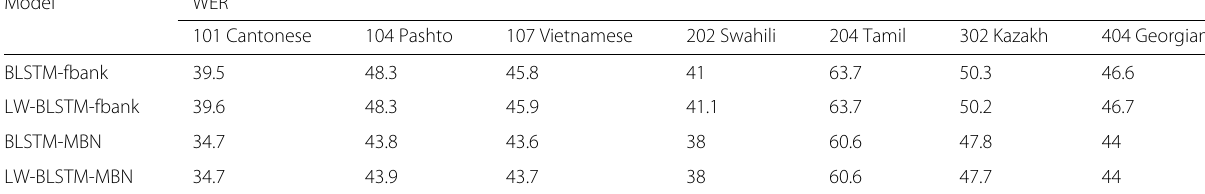
Table 9 WER (%) of the BLSTMs and LW-BLSTMs for all languages